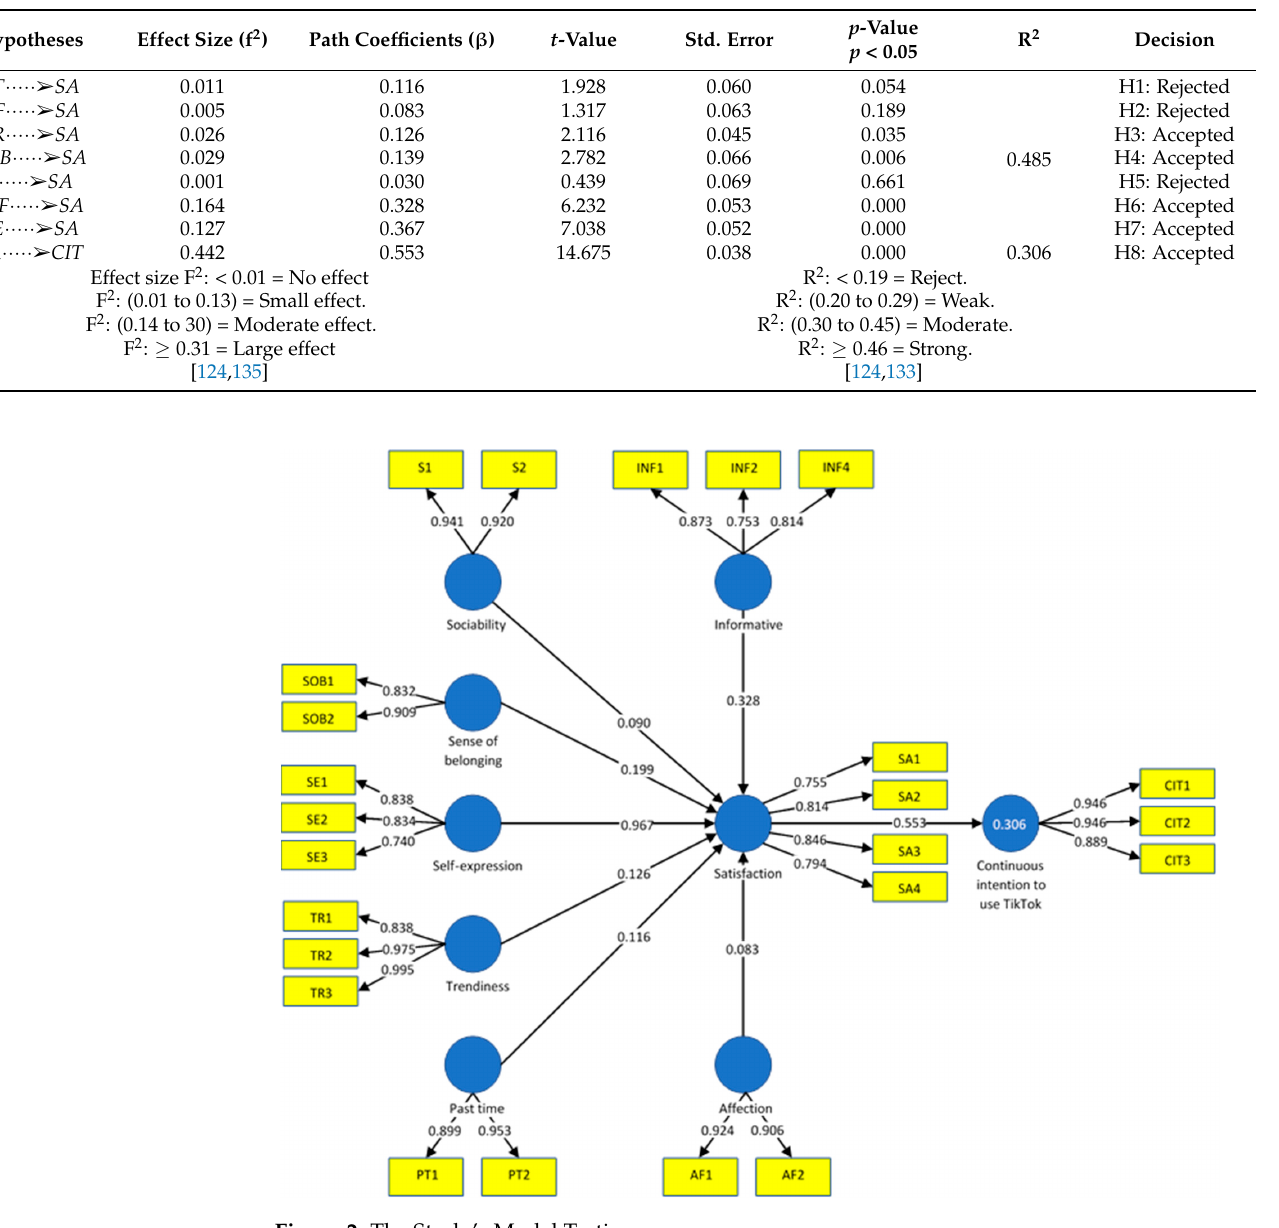
Table 6. The Results of Testing Hypotheses.